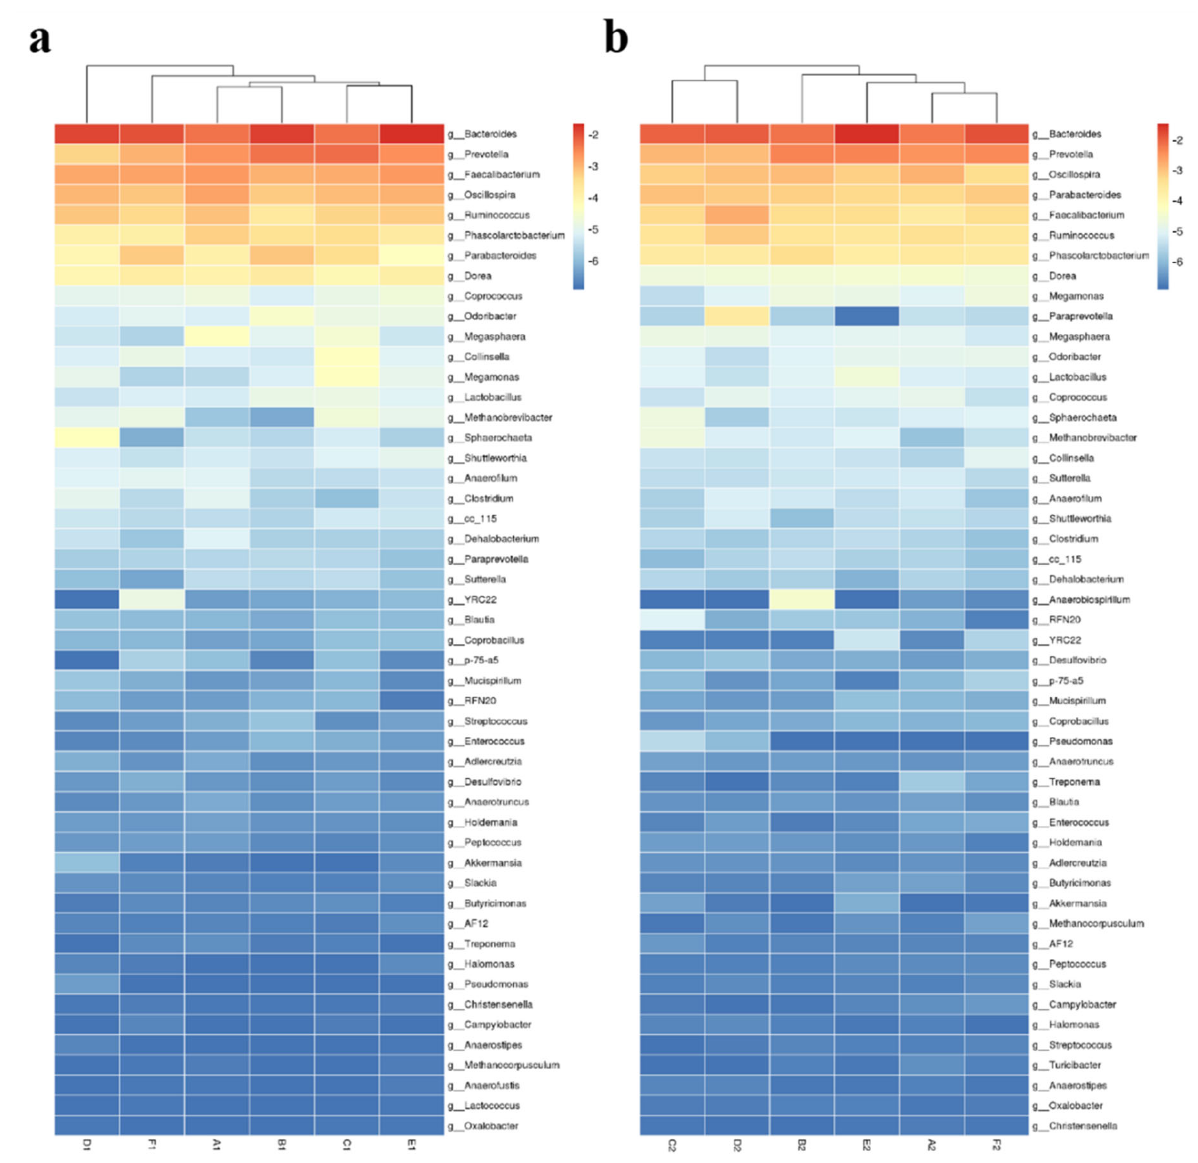
Figure 6. The heat map (grouped by column, the bacteria were screened and ranked as the top 50 of the relative abundance) of the microbial composition in the cecum of broiler chickens at the ge ‐ nus level of ( a ) day 28 and ( b ) day 56. The heat map indicates the relative abundance of each genus in different groups, and the darkness of the color indicates the ranking: the darkest red marks the highest value, and the darkest blue marks the lowest value.